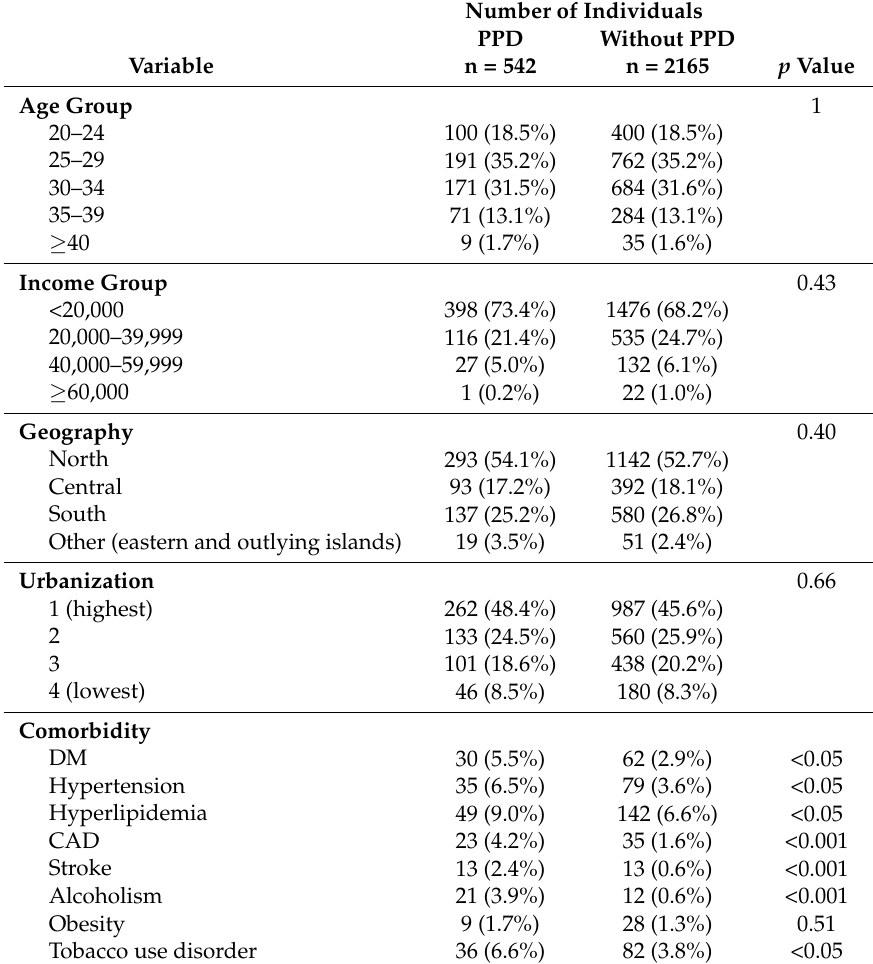
Table 1. Clinical and demographic characteristics of the study